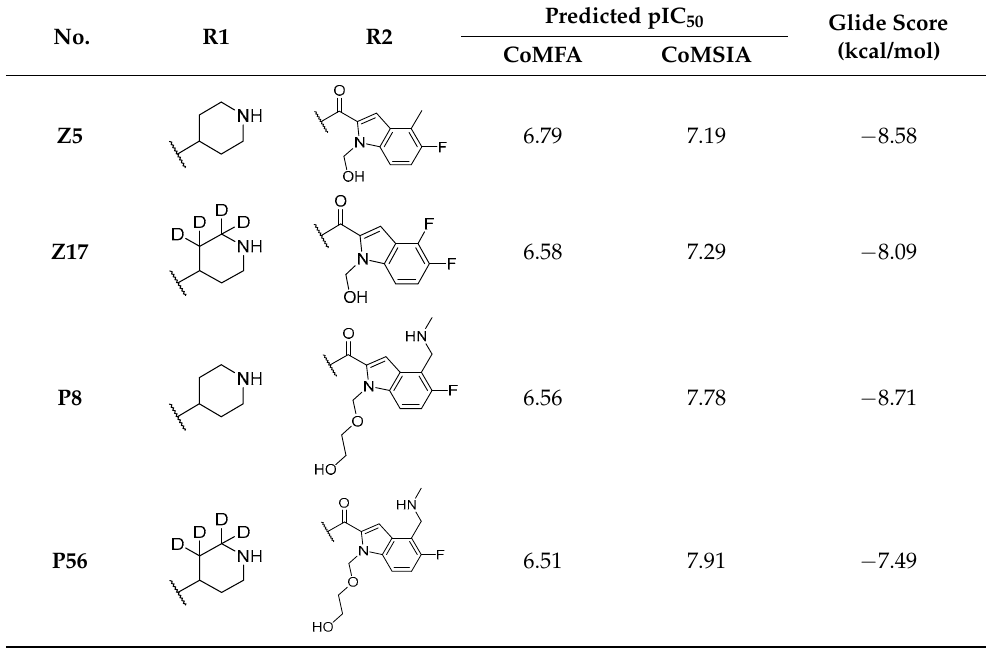
Figure 6. The RMSD results of the four systems. ( A ) The RMSD values of the complexes in the four systems. ( B ) The RMSD values of the ligands in the four systems. Figure 7 indicates that the superposition of the docking structure and MD average structure during MD equilibrium stage for each system. It was worth noting that the four compounds are still located well in the substrate binding region, which share the same binding mode with a “U-shaped” conformation. Furthermore, the hydrophobic and polar interactions between the compound and surrounding residues are favorable for maintain- ing the stability of the complex. Amazingly, as shown in Table 5, the hydrogen bonds between the four compounds and the residue Asp555 as well as the arene–cationic inter- action between the compound D1 and Phe538 were stable during the MD simulations. Compared with LSD1–18x, during the simulations of LSD1–D1 and LSD1–D4, the hydro- gen bonds Asp555=O ⋯ HN were kept, and the bond energies were almost the same ( − 13.2 kcal/mol, − 13.7 kcal/mol versus − 13.3 kcal/mol). Furthermore, due to the introduced -NH 2 group, two more stronger H-bonds, namely Glu559=O ⋯ HN and Pro808=O ⋯ HN, with a bond energy of − 20.1 kcal/mol, − 13.3 kcal/mol and − 18.2 kcal/mol, − 5.8 kcal/mol, were formed for LSD1–D1 and LSD1–D4. However, during the simulation of LSD1–Z17, the H-